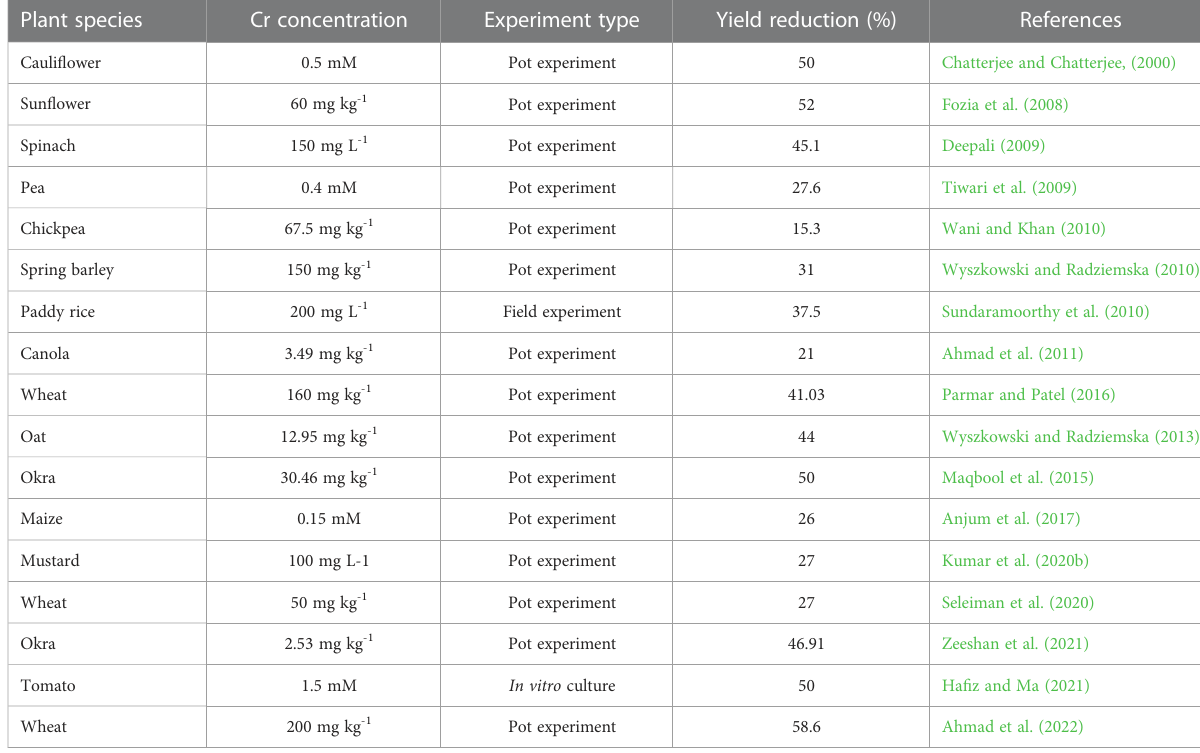
TABLE 1 Effect of chromium stress on yield of some representative fi eld